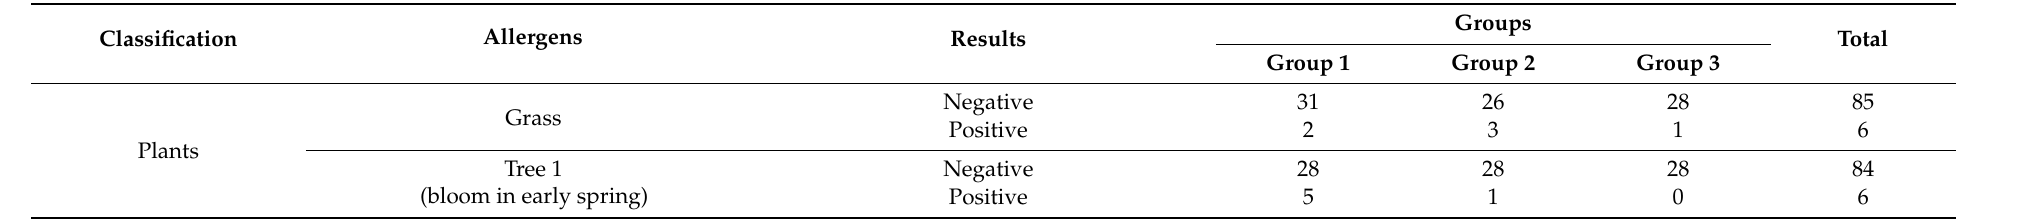
Table A4. Result Table of Participant’s Allergy